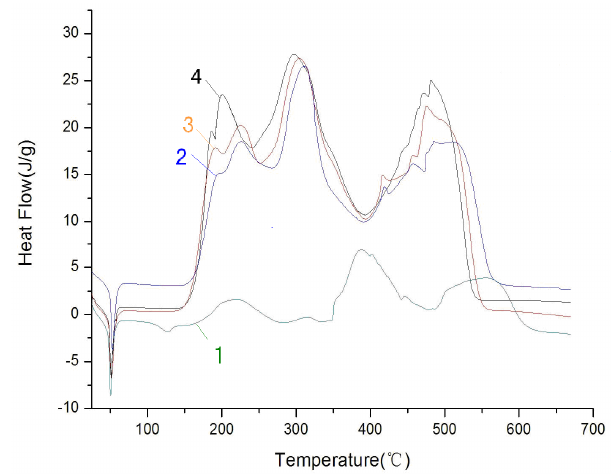
Figure 4. The DSC curves of pretreated paraffin in air with different